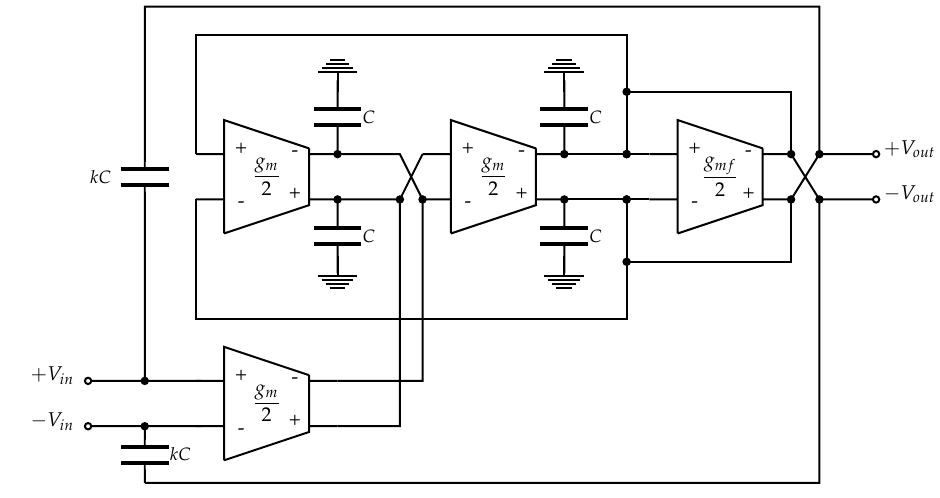
Figure 5. Q enhanced bandstop gm-C biquad filter.